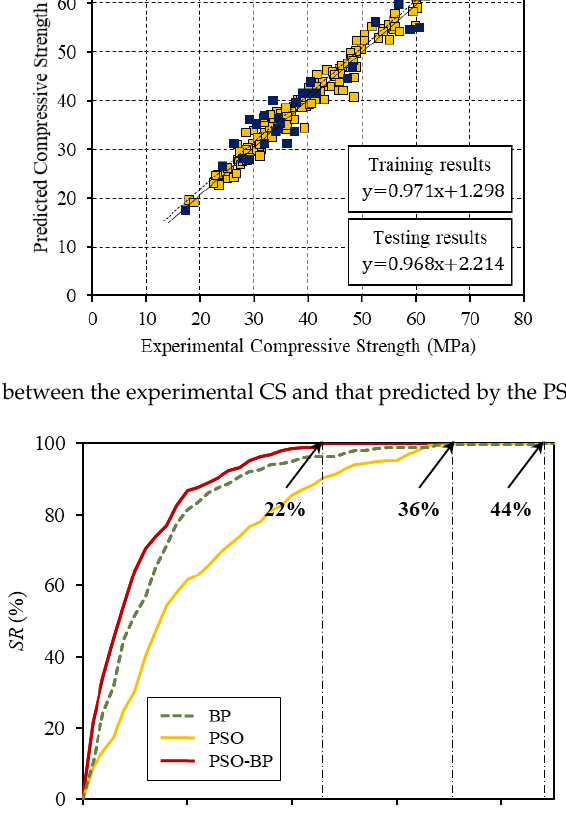
Figure 7. Percentage of data that have equal or smaller relative error than the specified error criterion ( SR ) for the developed models. Table 5. Values of the SR for the developed models.